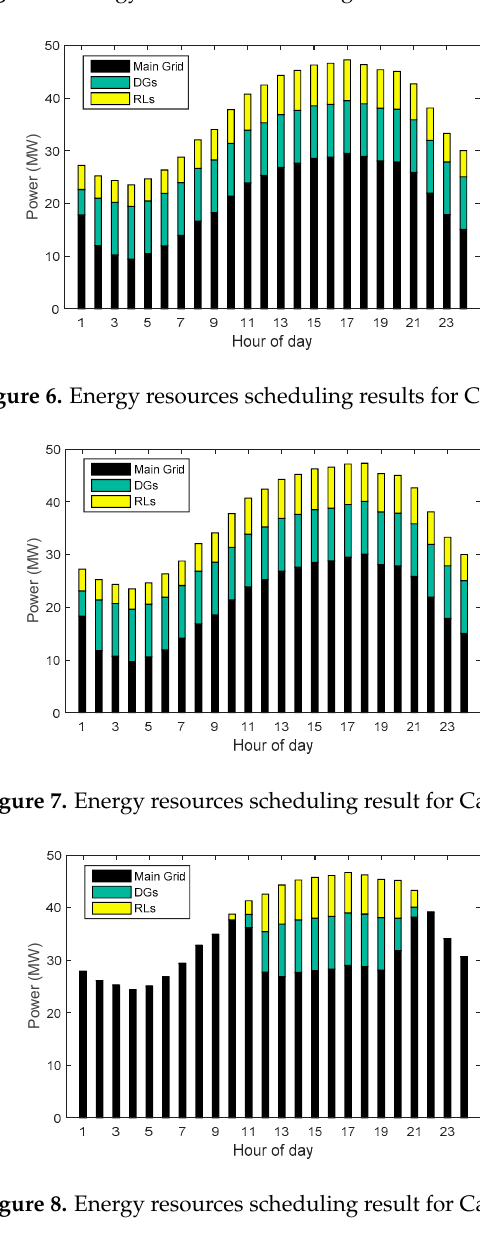
Figure 5. Energy resources scheduling results for Case 1. Energies 2016 , 9 , 311